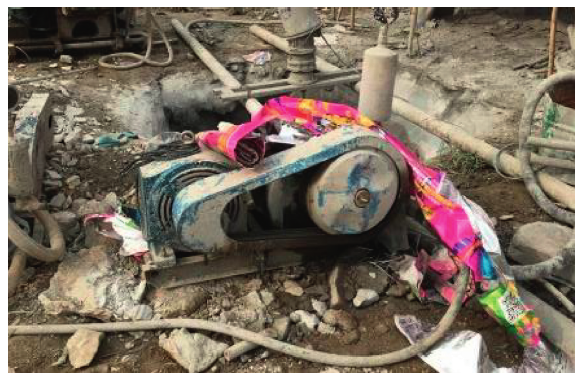
Figure 11: The water pump.